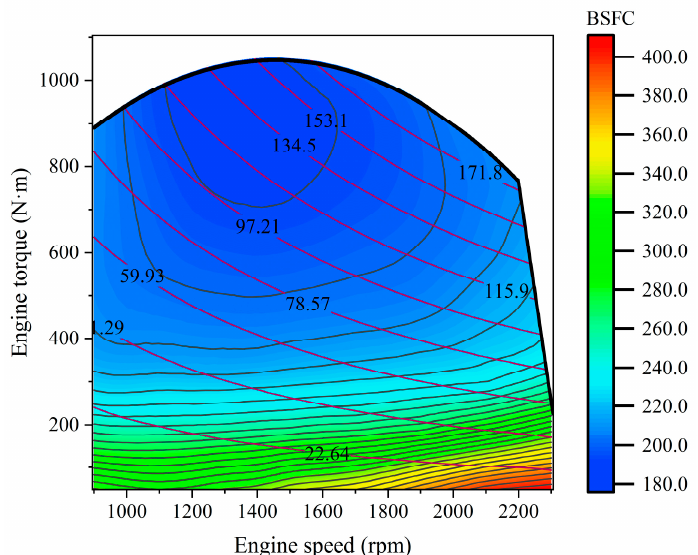
Figure 8. The engine mapping characteristics.